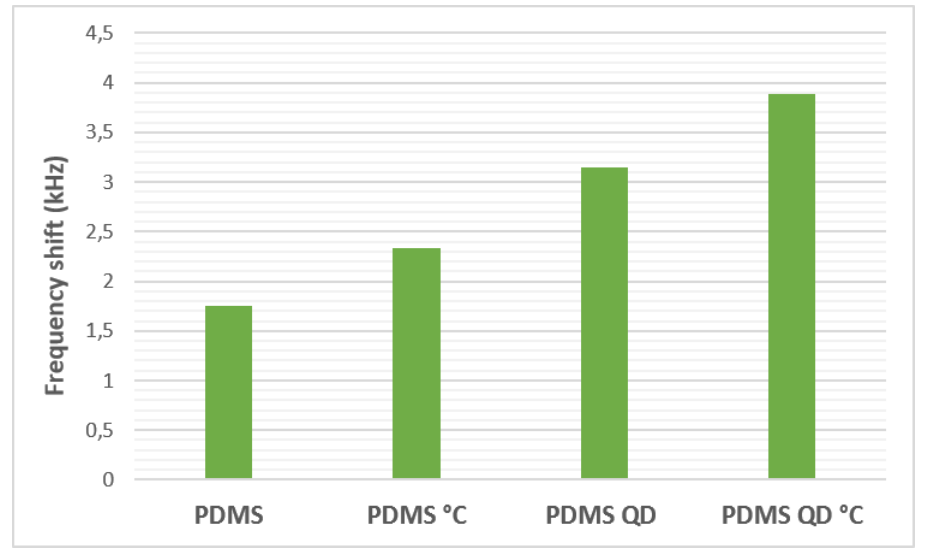
Figure 6. The frequency shifts for the sensor with polydimethylsiloxane (PDMS) at an 8% concentration of hydrogen.